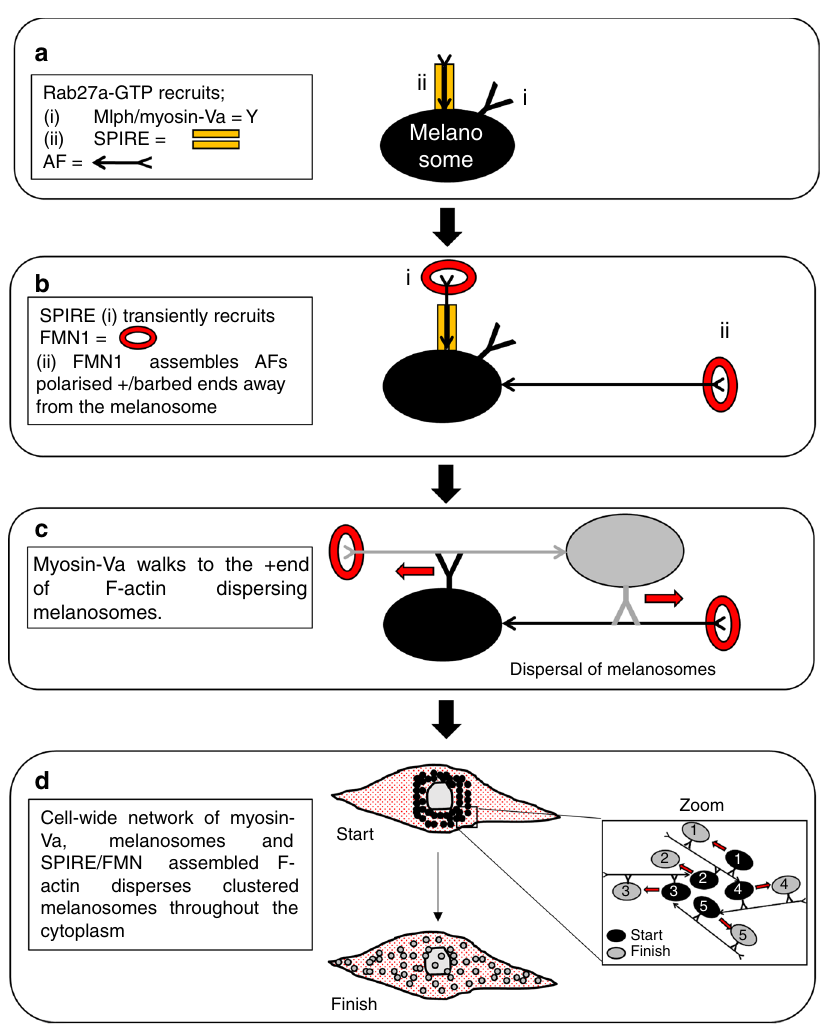
Fig. 9 A model indicating how Rab27a could regulate AF-driven melanosome transport by integrating the activity of myosin-Va, and SPIRE1/2 and FMN1. See main text for details. In a , a model melanosome, myosin-Va, SPIRE and an actin fi lament are shown, Rab27a is not shown for clarity but is present on the melanosome membrane. In b , the activity of FMN1 in extending the + end of melanosomes from melanosomes is shown. In c , grey and black colours indicate AF and myosin-Va associated with melanosomes of the same colour. In d , grey and black colours indicate the position of numbered melanosomes at the start and fi nish of an episode of dispersive